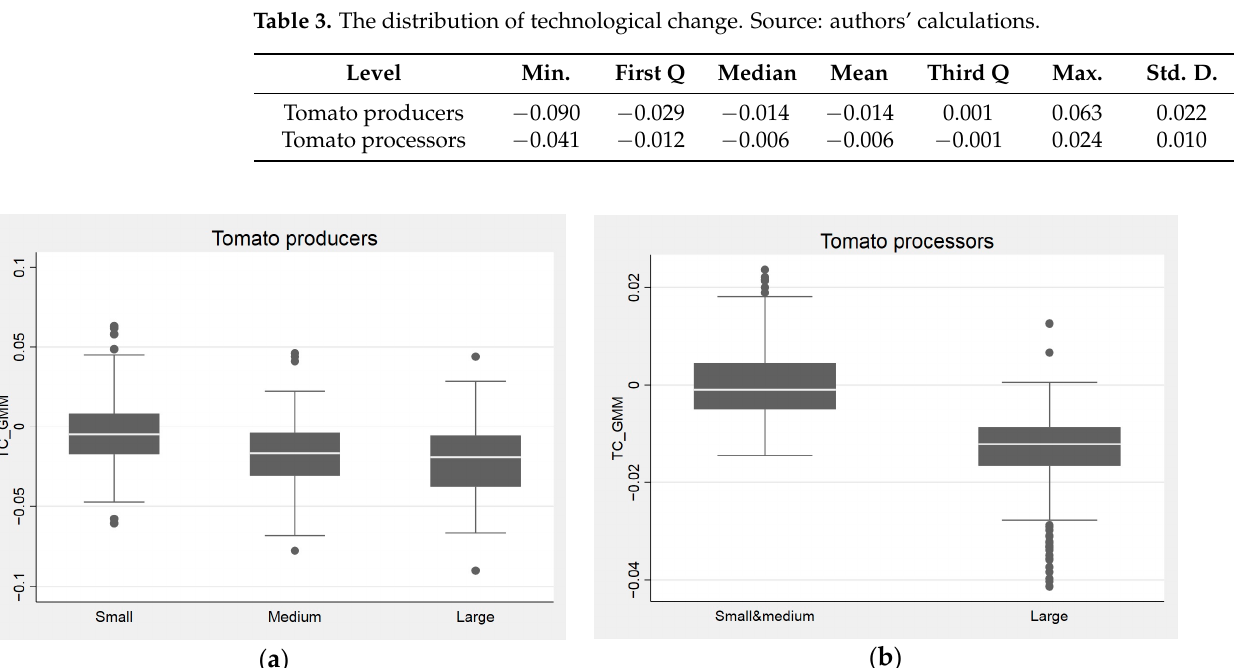
Figure 1. Development of technological change. Source: authors’ calculations.